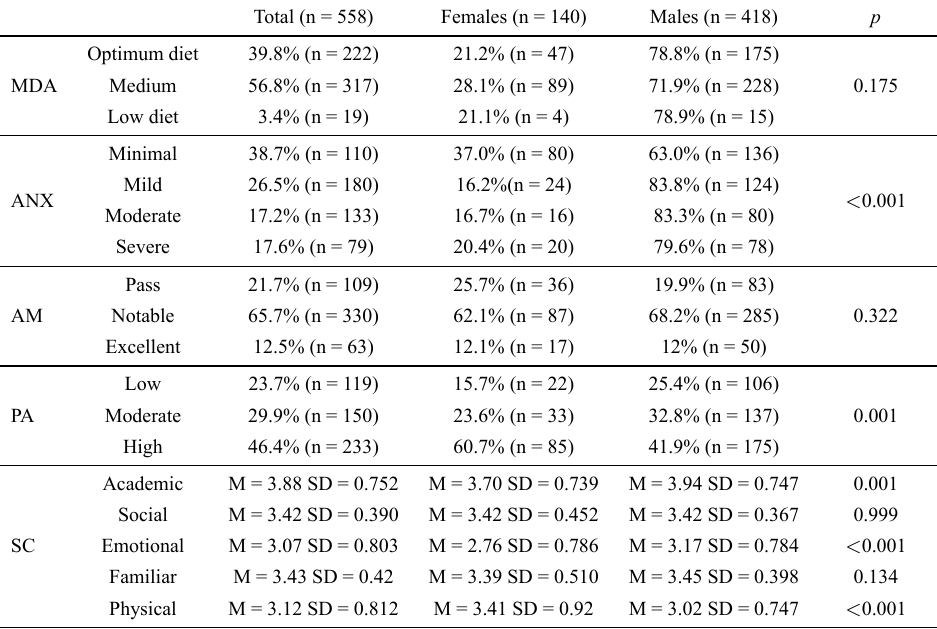
Table 1. Characteristics of study sample according to sex of participants.